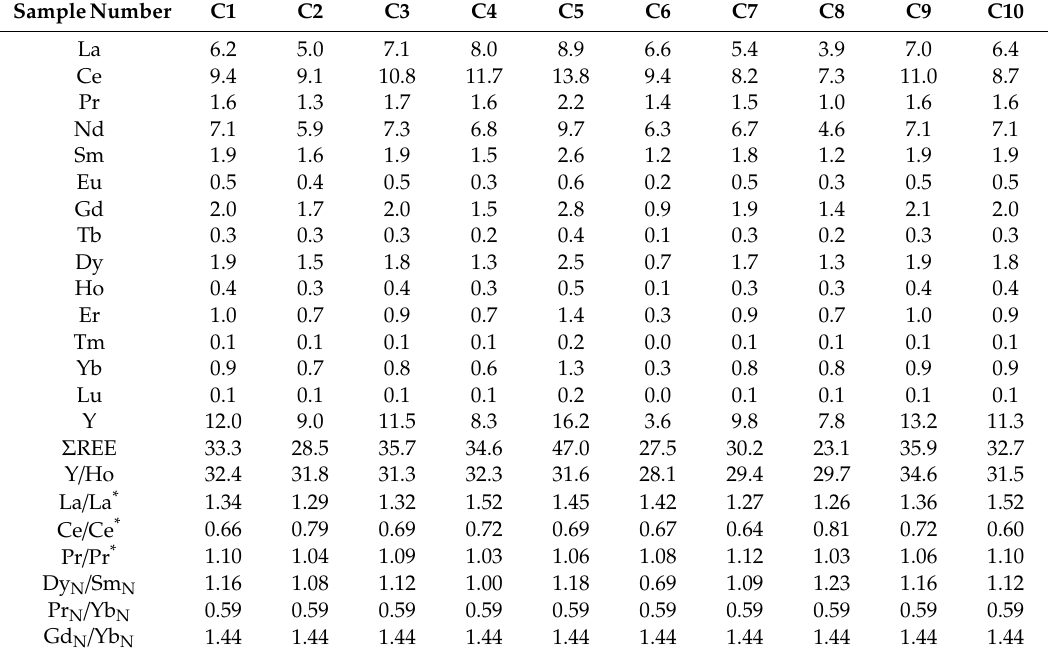
Table 2. Rare earth element compositions ( µ g / g) of tubular carbonates from the northern South China